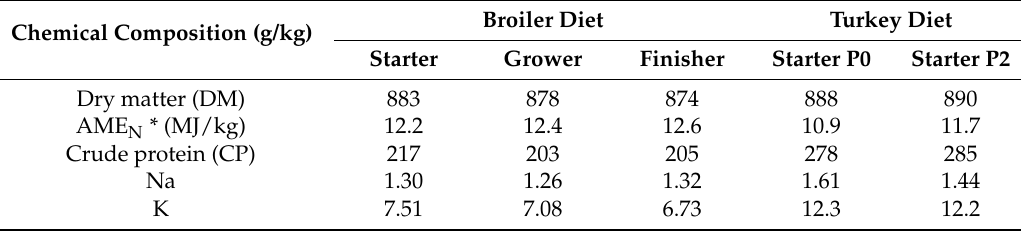
Table 1. Analysed nutrient contents of the diets during the whole experimental period (g/kg as fed). Broiler Diet Turkey Diet Chemical Composition (g/kg) Starter Grower Finisher Starter P0 Starter P2 Dry matter (DM) 883 878 874 888 890 AME N * (MJ/kg) 12.2 12.4 12.6 10.9 11.7 Crude protein (CP) 217 203 205 278 285 Na 1.30 1.26 1.32 1.61 1.44 K 7.51 7.08 6.73 12.3